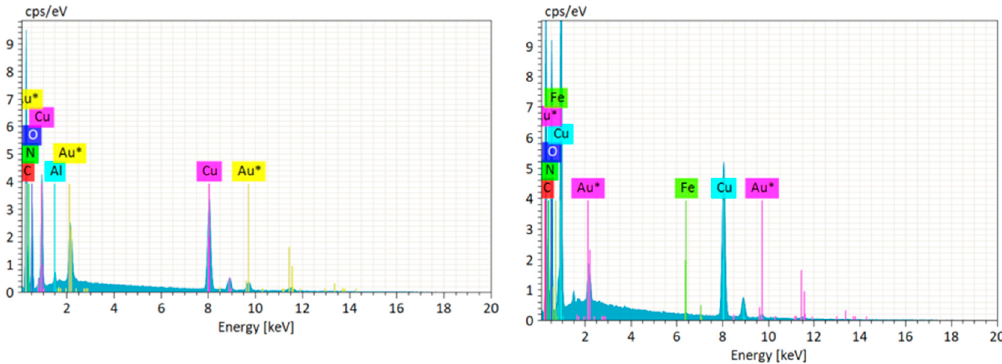
Figure 10. EDX spectra of 9 ( left ) and Fe@ 9 ( right ).